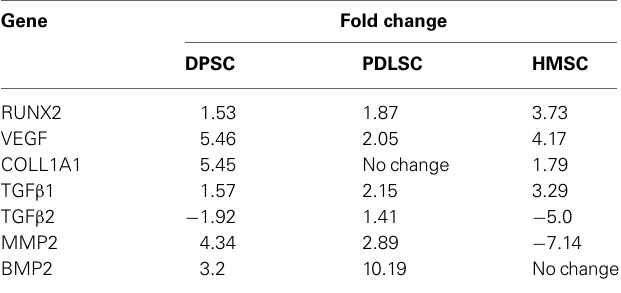
Table 2 | List of differentially expressed genes.